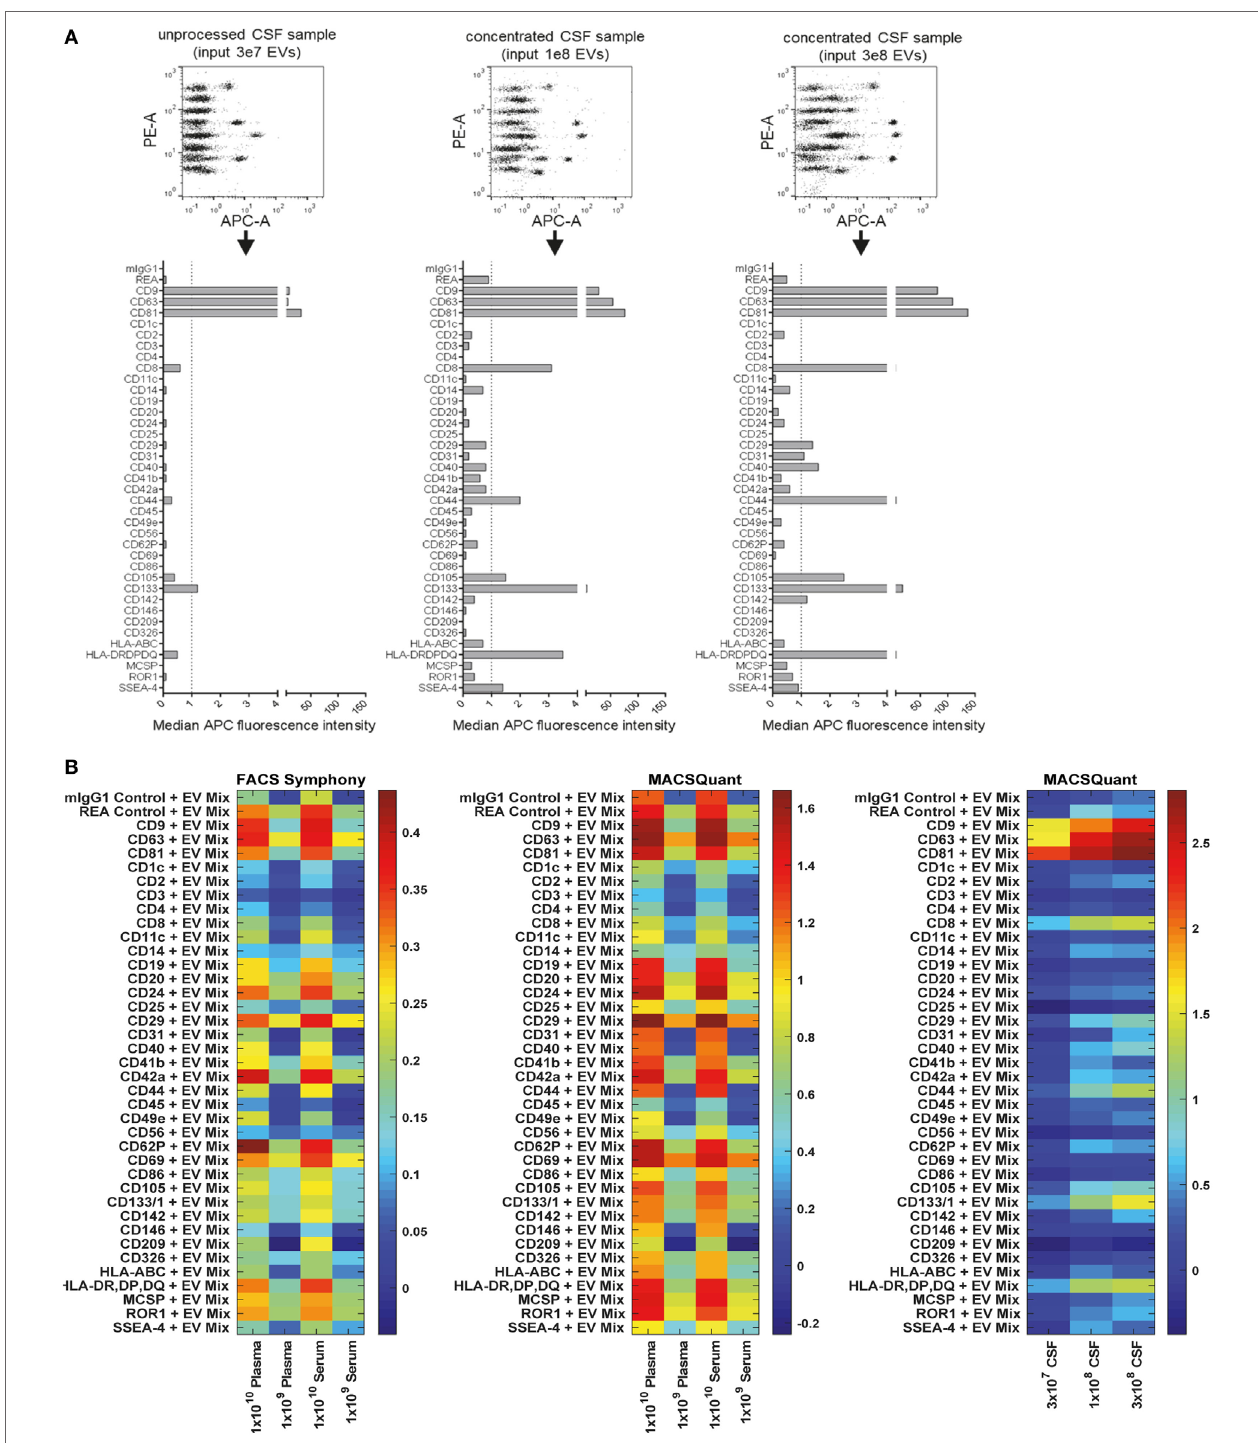
FigUre 8 | Assessment of extracellular vesicle (EV) surface signatures in human biological fluids. (a) Pre-cleared cerebral spinal fluid (CSF) samples measured in three dilutions to study the relevance and specificity of markers with median fluorescence intensity (MFI) close to background levels by observing the MFI increase with increasing EV input amounts. The markers clearly detected as positive in unprocessed CSF (CD9, CD63, CD81, CD133) were consistently detected in all CSF samples analyzed (not shown, eight donors analyzed). (B) Heatmap comparison of plasma and serum samples analyzed on the FACS Symphony (left) and MACSQuant (middle) instruments with two different input amounts. A heatmap of the CSF-derived samples from (a) is also shown for comparison. Scales are the log10 ratio of APC intensity of the capture beads + extracellular vesicles + antibody (CD9 + CD63 + CD81 = EV Mix) when compared to capture beads + antibody controls. See Figures S8–S12 in Supplementary Material for further information and Tables S2 and S3 in Supplementary Material for further details.